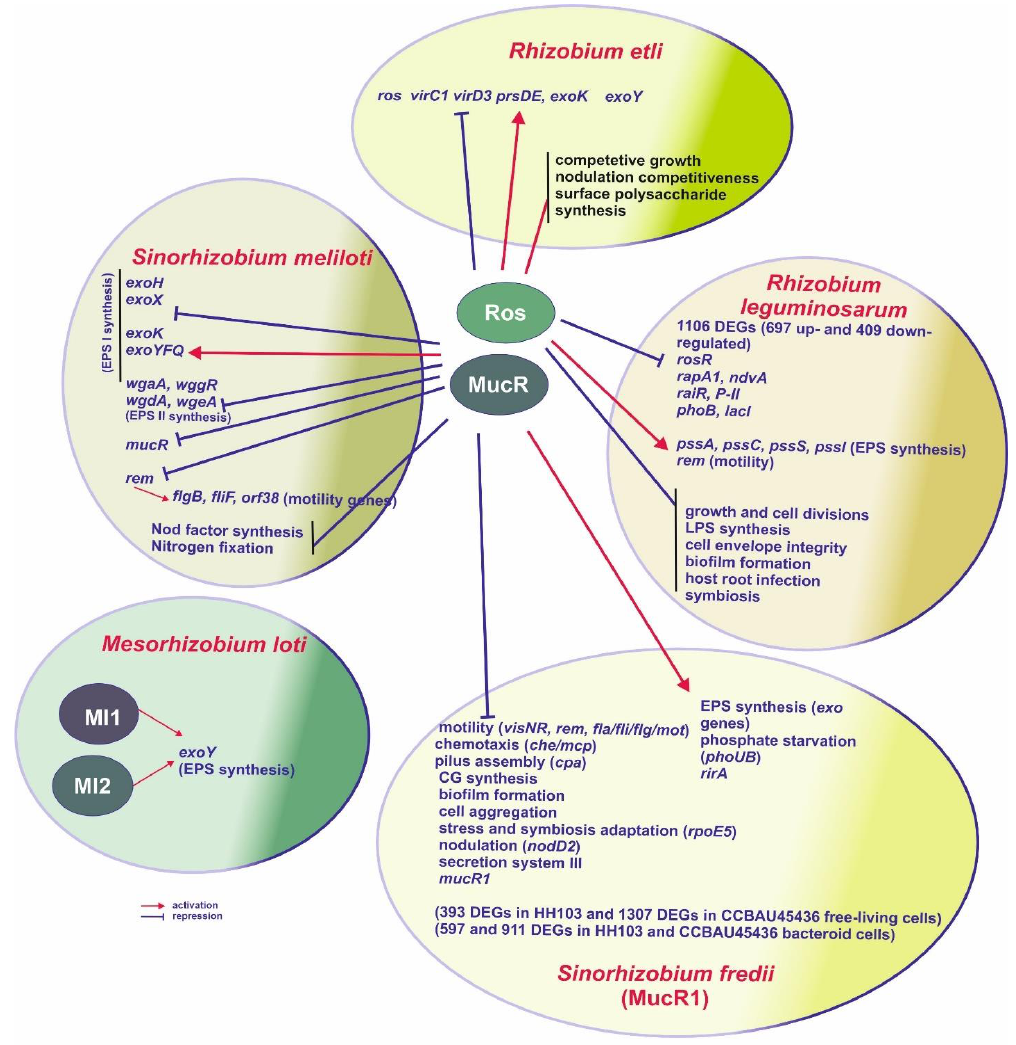
Figure 3. MucR/Ros proteins from different rhizobial species and their roles in regulation of expres- sion of various genes involved in several cellular processes and adaptation to environmental